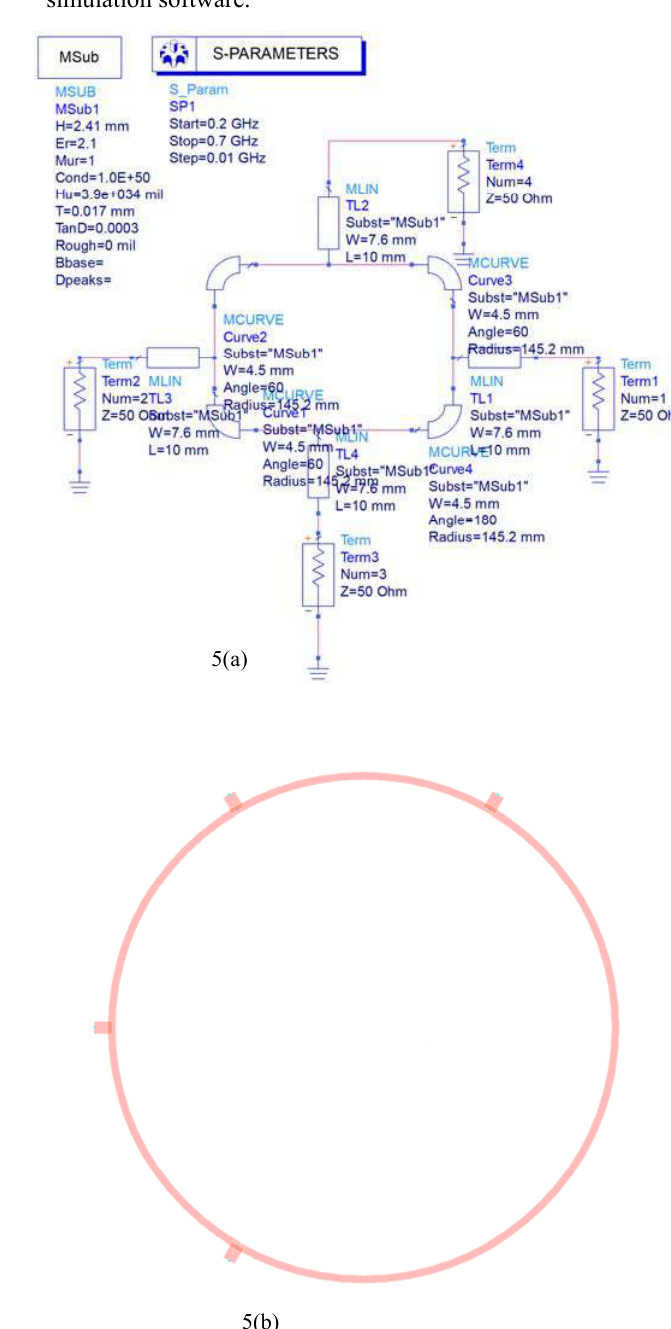
Fig. 4: Photograph of Rat-Race coupler